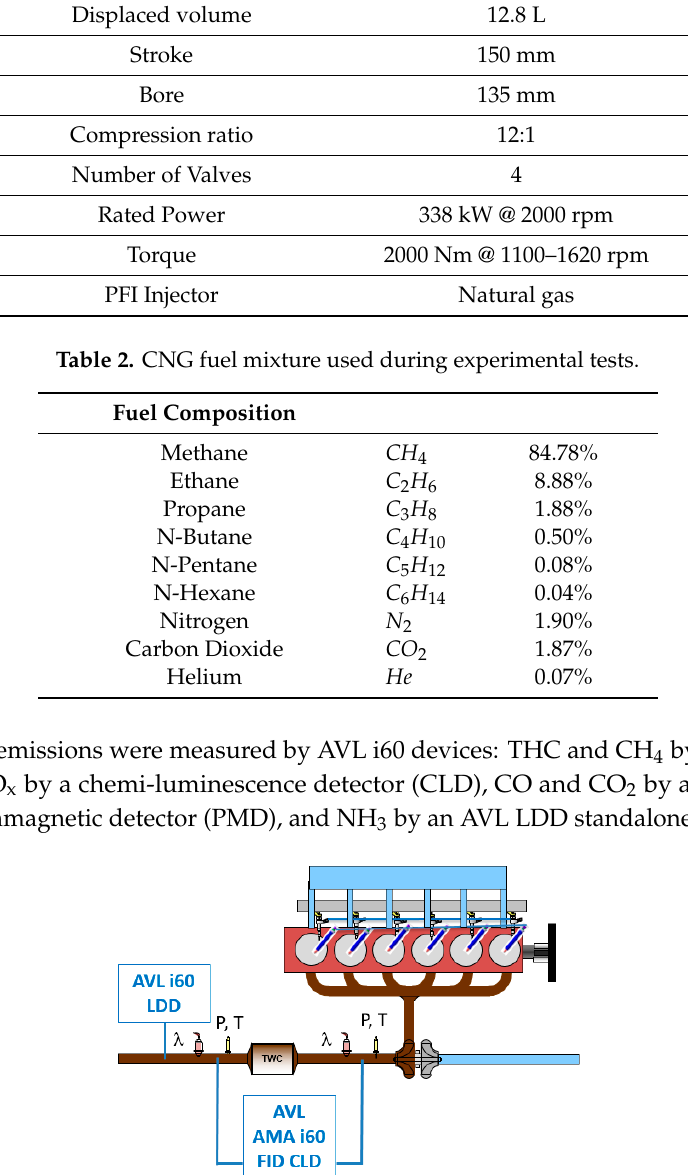
Table 1. Main features of the natural gas 6-cylidnder engine.